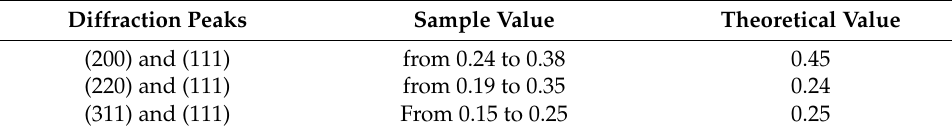
Table 3. Ratio between the intensities of the diffraction peaks for